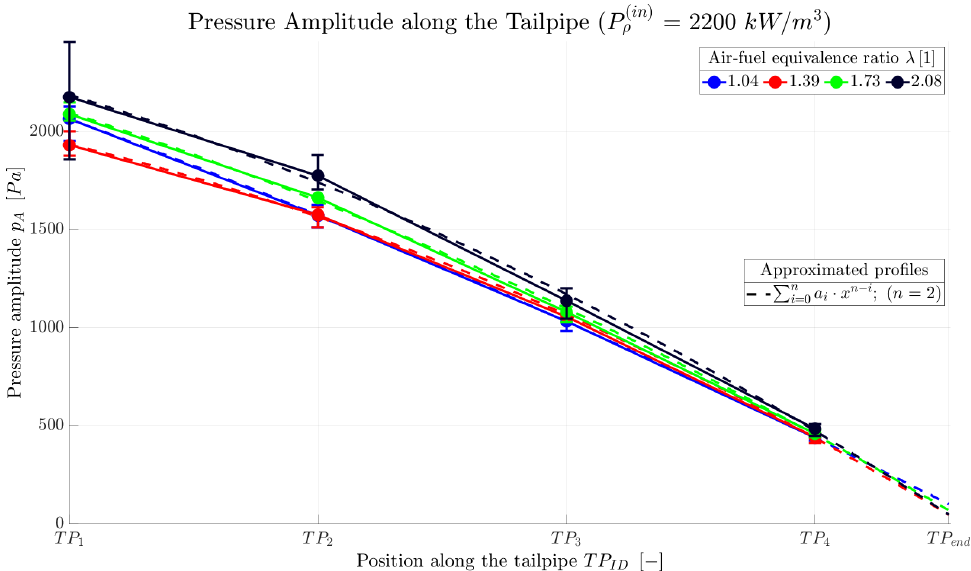
Figure 11. Pressure amplitude along the TP for one specific power density input. The solid lines connect the original data and the dashed curves display the pressure profile extrapolated to the tailpipe end, which was obtained through an approximation of the original data by a polynomial of the second